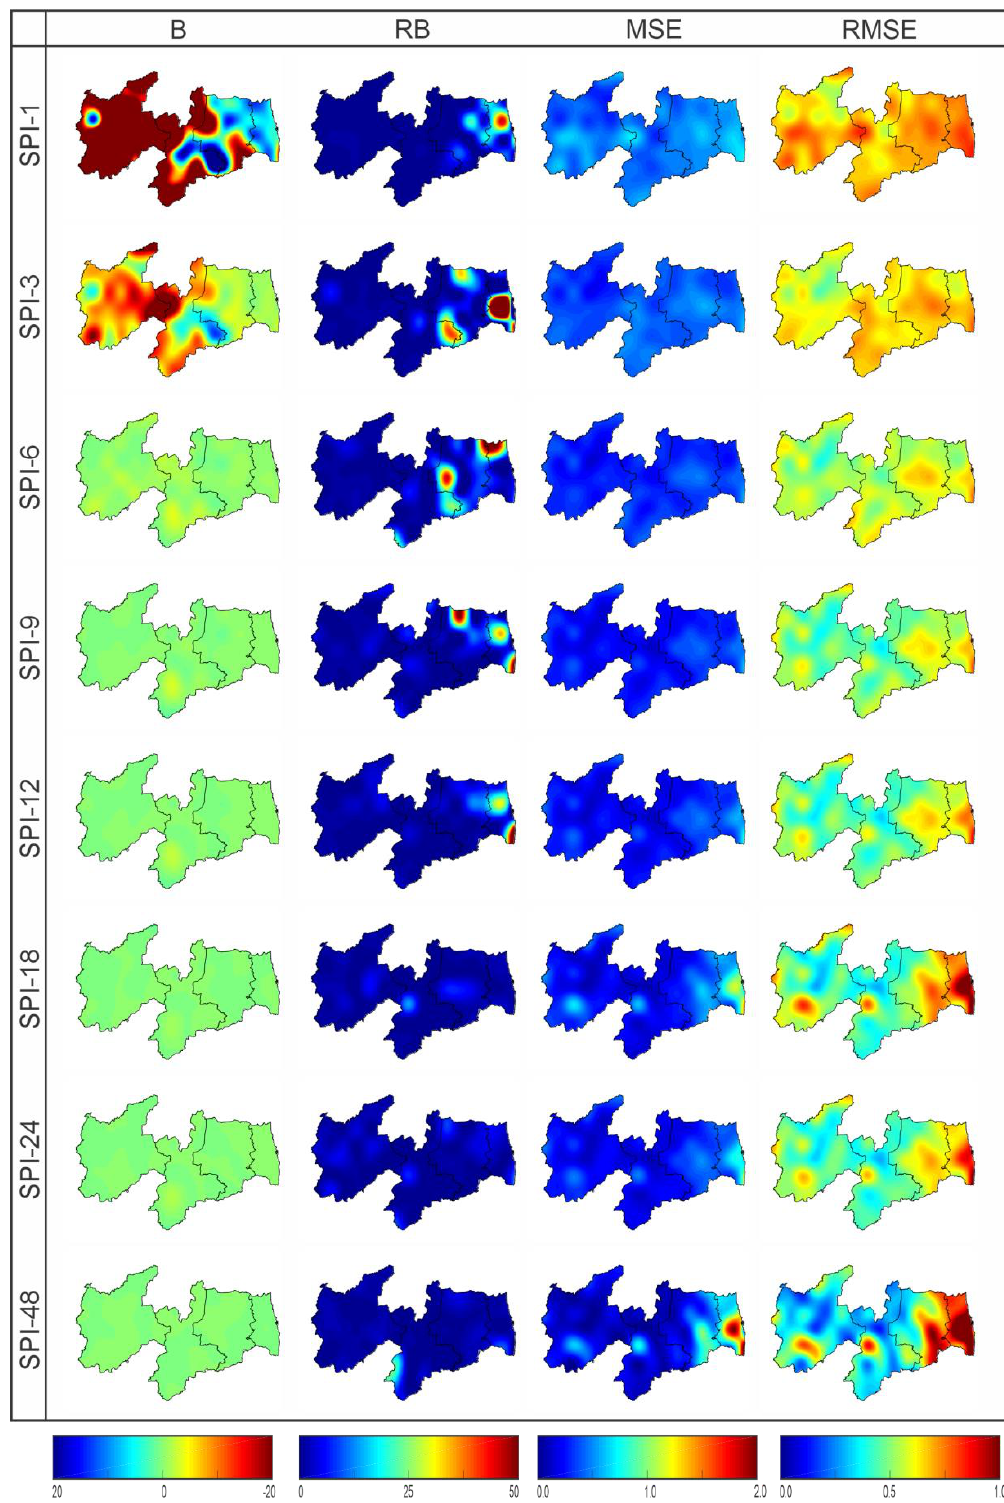
Figure 6. Spatial distributions of the B , RB , MSE and RMSE indices in Paraíba State.